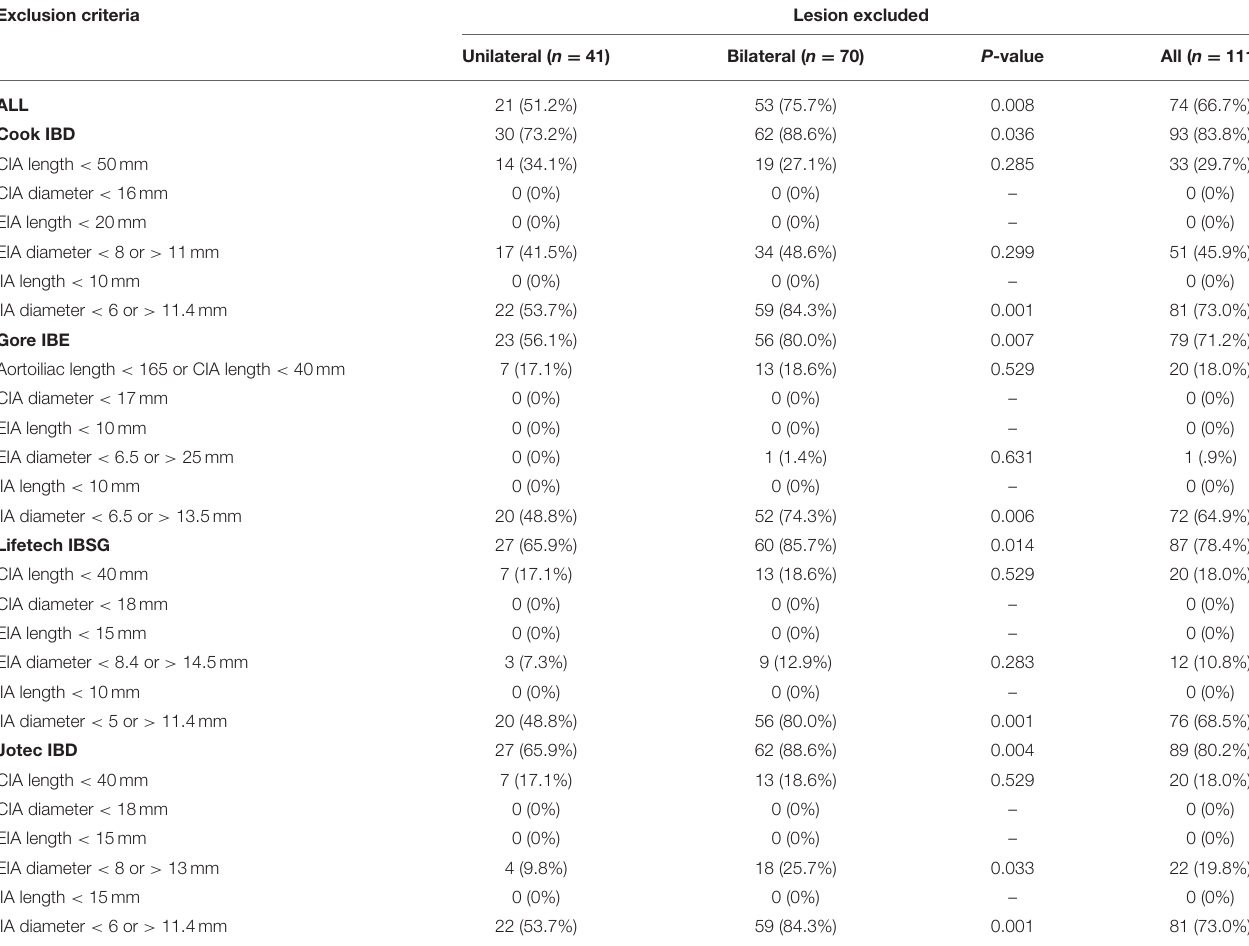
TABLE 4 | Anatomic reasons for exclusion and comparison for unilateral and bilateral lesions. Exclusion